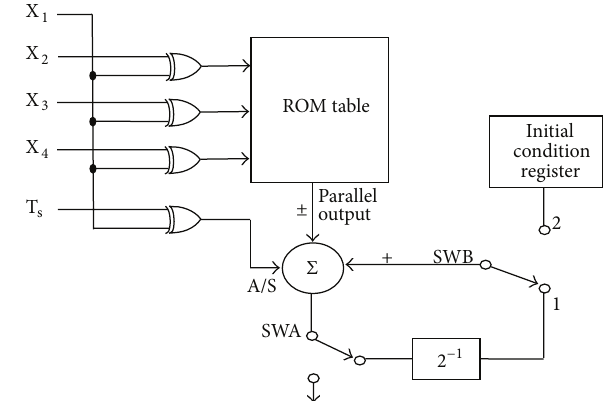
Figure 5: DA based filter architecture using XOR gate